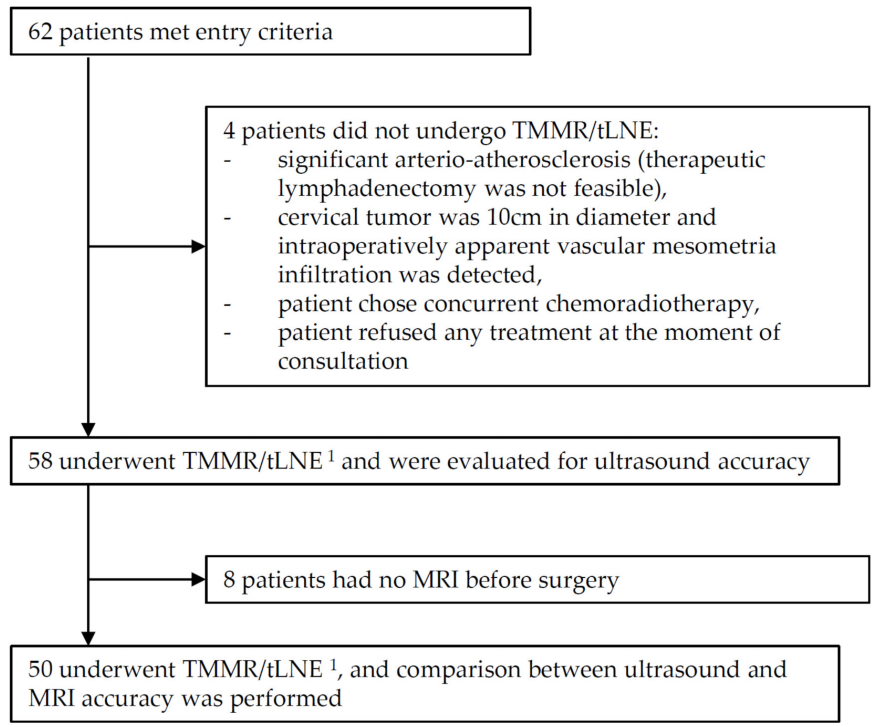
Figure 5. The flow of patients; 1 TMMR/tLND, total mesometrial resection, and therapeutic